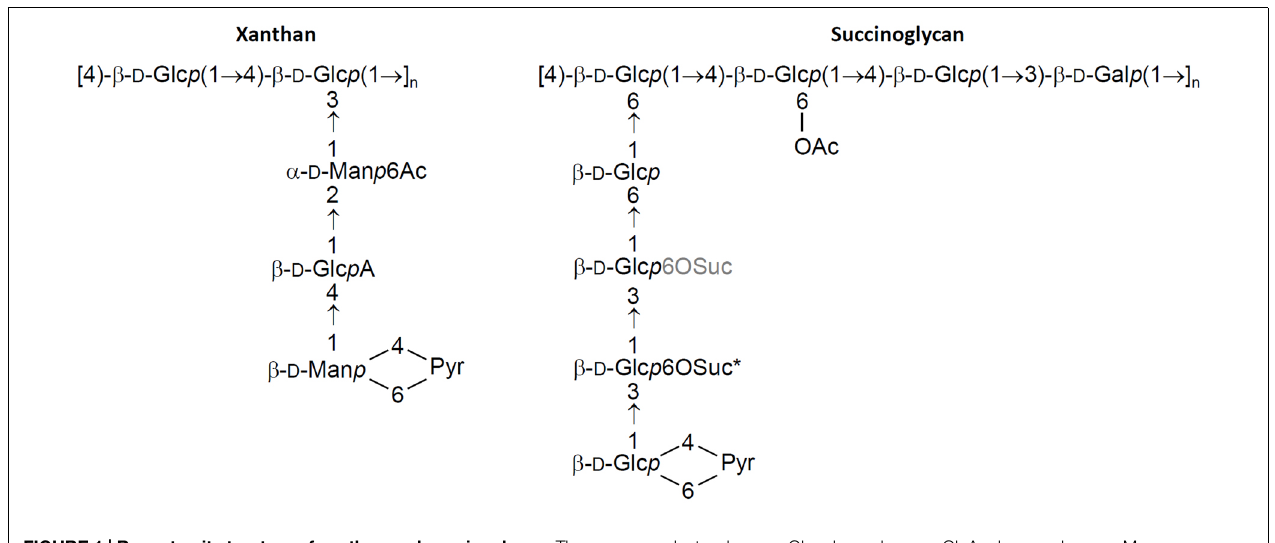
FIGURE 1 | Repeat unit structure of xanthan and succinoglycan. The polysaccharides consist of a variable number of these repeats. While carbohydrate structure is uniform along the polysaccharide chain, decorations with non-sugar groups are variable. Ac, acetyl group; Gal,